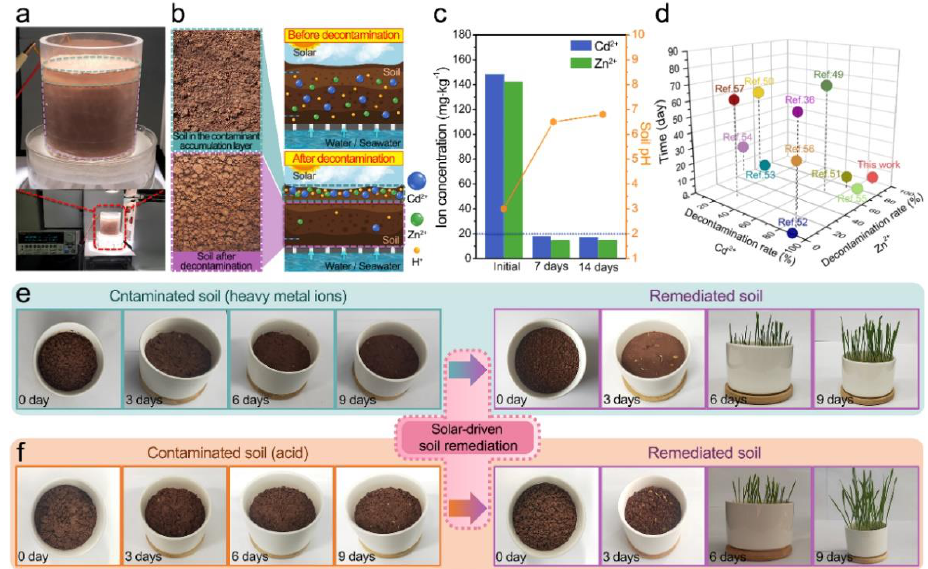
Figure 6. ( a ) Diagram of remediation of contaminated rocky land; ( b ) Photos of the contaminated soil layer enriched with heavy metal ions (top left) and the remediated soil layer (bottom left), and (right) a schematic diagram of the soil remediation process; ( c ) Heavy metal ion concentration in the soil and soil pH before and after remediation (7 and 14 days); ( d ) Plot of Zn 2+ and Cd 2+ removal efficiency, removal time of solar-driven ISUM compared to other commonly used techniques; ( e , f ) Growth of wheat on different dates (day 0, 3, 6, and 9) in heavy metal and inorganic acid contaminated rocky land compared to remediated rocky land.